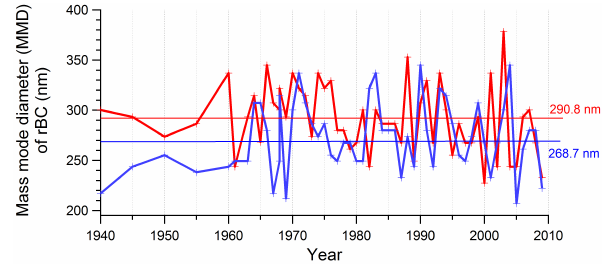
Figure 5. Time series of the mass mode diameter (MMD) of sea- sonal rBC size distributions for the period 1940–2009. The MMD was obtained by fitting a log-normal curve to the measured distri- bution. Horizontal lines stand for the geometric means for summer (red) and winter